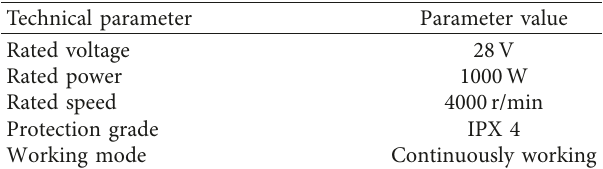
Table 2: Main technical parameters of the designed